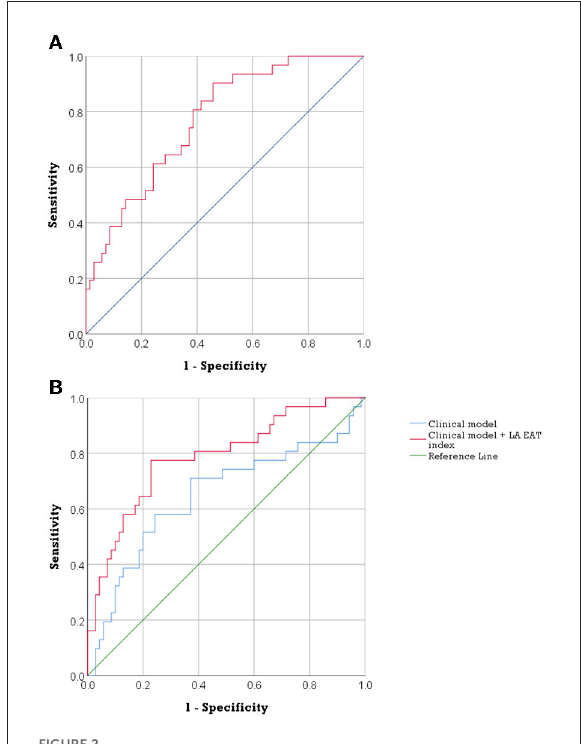
FIGURE2 The predictive accuracy of LA EAT in post ablation AF recurrence. (A) ROC curve of LA EAT index in the prediction of AF recurrence. (AUC = 0.771, 95% confidence interval 0.68–0.86, p < 0.001). (B) ROC curves describing the discriminatory performance of integration of LA EAT index with the clinical model in the prediction of AF recurrence [AUC 0.788 (95% CI, 0.69–0.89) compared to 0.648 (95%CI, 0.52–0.78), DeLong test p = 0.044]. AF, atrial fibrillation; AUC, area under the curve; EAT, epicardial adipose tissue; LA, left atrial; ROC, receiver operating